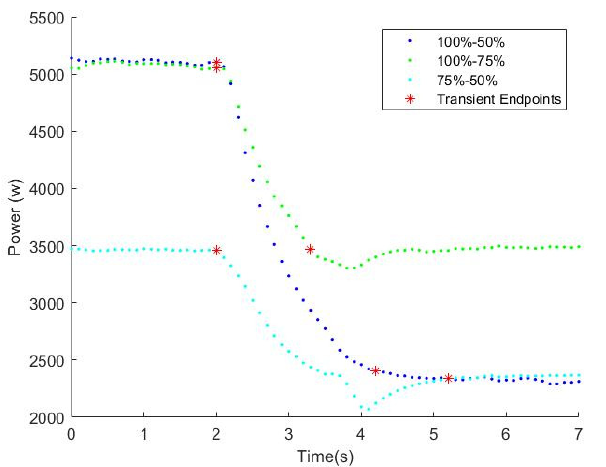
Figure 10. Negative throttle change DTC transient experimentation results.